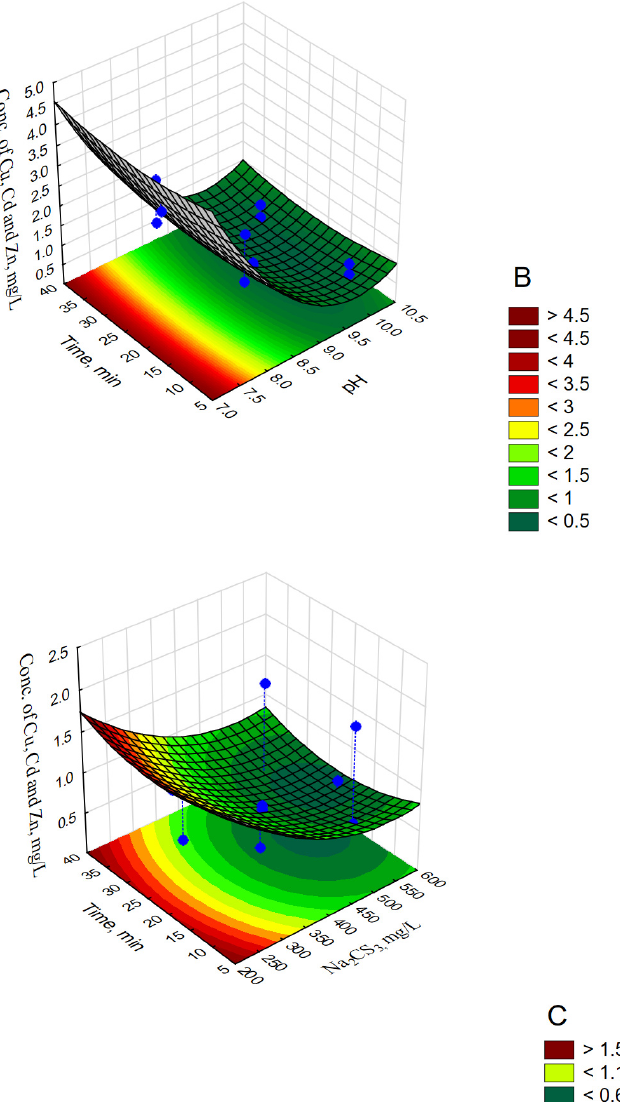
Figure 3. Response surface plots for ∑ Cu,Cd,Zn , mg/L with respect to pH and Na 2 CS 3 , mg/L ( A ); pH and Time, min ( B ); Na 2 CS 3 , mg/L and time, min ( C